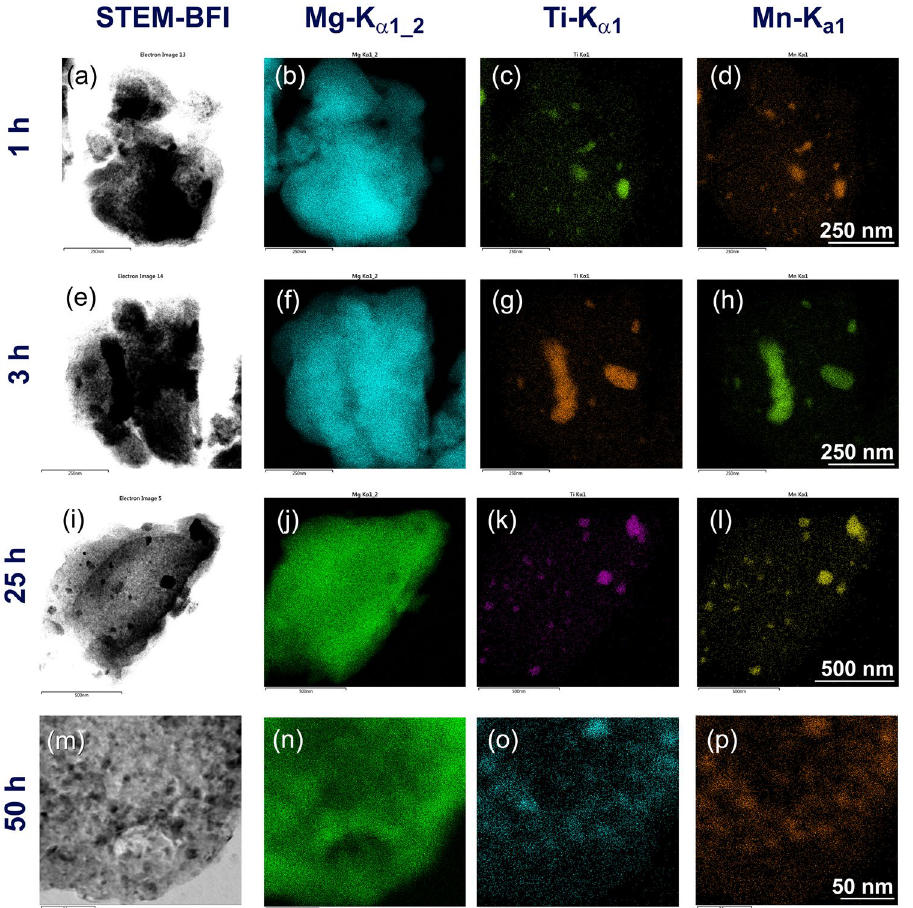
Figure 2. Influence of RBM time on morphological and elemental distributions beyond the nanoscale level for nanocomposite MgH 2 /5 wt.% TiMn 2 powders. The STEM-BFIs for the powders obtained after 1, 3, 25 and 50 h of RBM time are shown in ( a , e , i , m ), respectively. The Mg-K α 1-2 , Ti-K α 1 and Mn-K α 1 for the powders obtained after 1 h and 3 h (early stage of RBM time) are shown together in ( b – d , f – h ), respectively. The EDS elemental mapping images shown in ( j – p ) are corresponding to Mg-K α 1-2 , Ti-K α 1 and Mn-K α 1 for those samples obtained after 25 h ( i ) and 50 h ( m ),